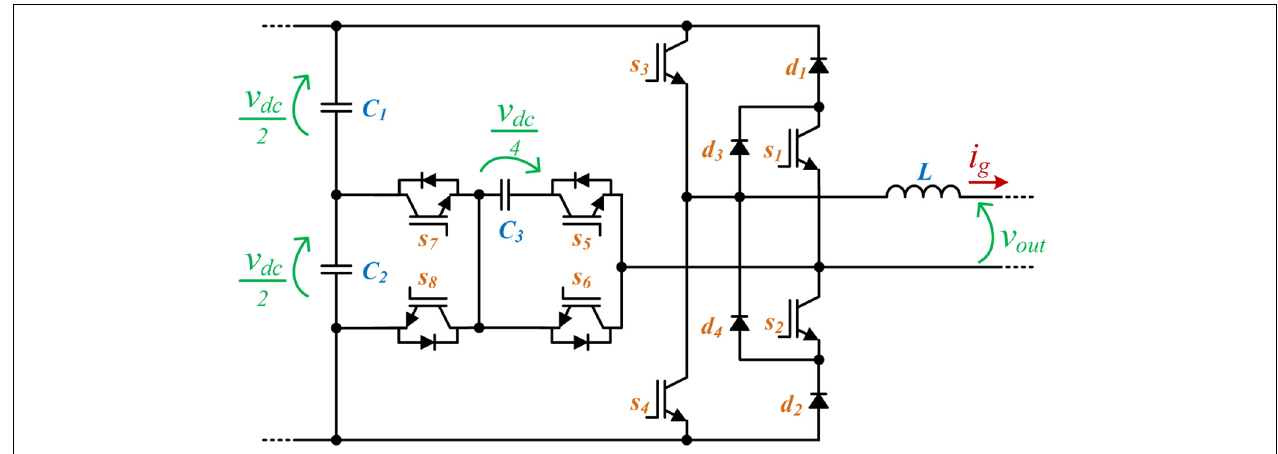
FIGURE 3 | Topology proposed in Masaoud et al. (2014).